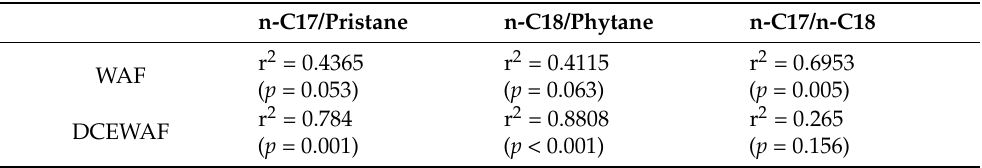
Figure 1. Esterase activities measured by means of MUF oleate hydrolysis and oil concentrations in the surface water incubation (case study 1). ( A ): Time courses of esterases (average rates of n = 3; ± standard deviations) in the two oil treatments (WAF and DCEWAF) and the non-oil control water. Note that the elevated enzyme activities in DCEWAF at day 0 could have been induced during the overnight treatment of the amendment (see [41]). ( B ): Correlation between esterases and estimated oil equivalents (EOE). ( C ): Correlations between esterases and total hydrocarbons. Plot B and C show hydrolysis rates from the three replicates (note the outlier in esterase activity of one of the replicates at day 2 in the WAF, B). Esterase activities and EOE are replotted from [48]; total hydrocarbon concentrations are from GRIDCII https://data.gulfresearchinitiative.org/data/R4.x263.000:0053 (accessed on 11 April 2022). Table 3. Pearson correlation coefficient (r 2 ) and p -values for surface water activities of esterase and oil biodegradation indicator